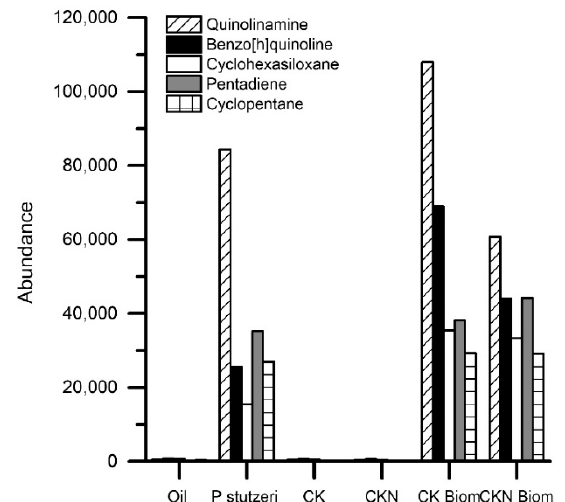
Figure 8. Biocatalysis products from crude oil removal by activated carbons prepared by chemical activation of olive stones with potassium hydroxide (CK), functionalized with melamine (CKN), P. stutzeri on CK (CK Biom.) and CKN (CKN Biom.) materials estimated by GC-MS analysis.